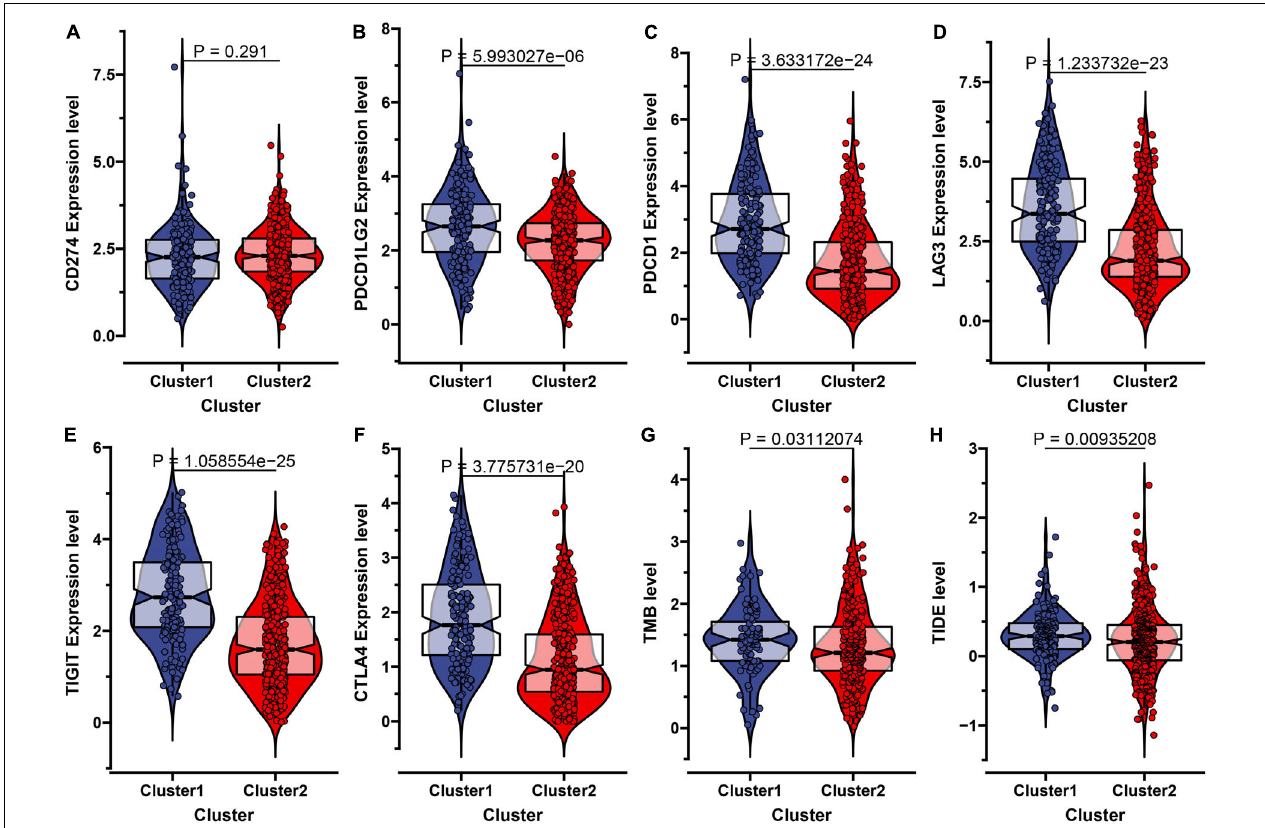
FIGURE 3 | Evaluation of the immunotherapeutic response of the two subtypes in ccRCC. (A–F) The expression level of six immune checkpoint inhibitors including CD274 (PD-L1), PDCD1LG2 (PD-L2), PDCD1 (PD-1), LAG3, TIGIT, and CTLA-4 in the two molecular subtypes. (G) The comparisons of TMB value between the two subtypes. (H) The Tumor Immune Dysfunction and Exclusion (TIDE) prediction score of the two